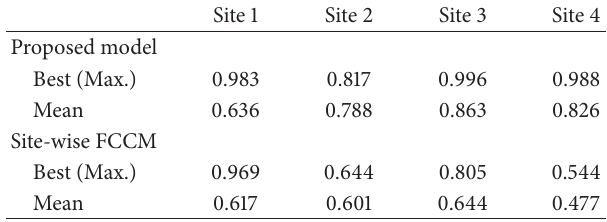
Table 3: Comparison of partition quality measured by correlation coefficients among item memberships (terrorist